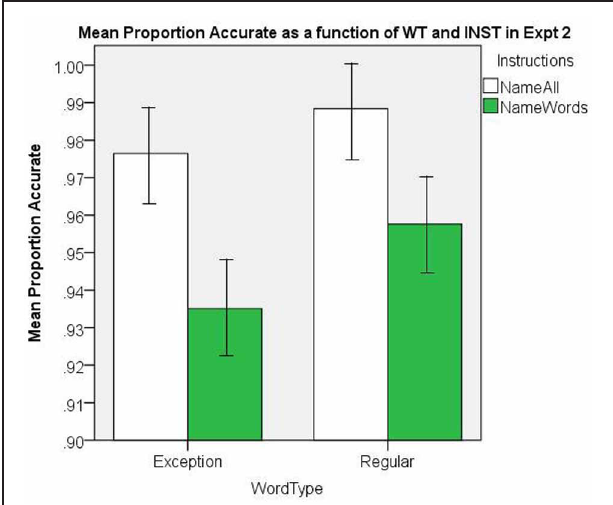
FIGURE 10 | Median Naming RDs (in ms) as a function of WT and INST in Experiment 2. The 95% C.I.s are presented as error bars using Loftus and Masson’s (1994) method. Co-efficients relating WF to RT (ms/log 10 HALWF) are presented in parentheses above each error bar, and co-efficients relating SND to RT (ms/unit inverseNcount) are presented in parentheses below each error